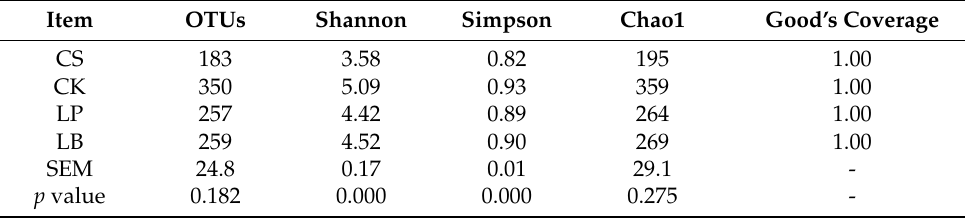
Table 2. α -Diversity index of bacterial community in whole crop corn